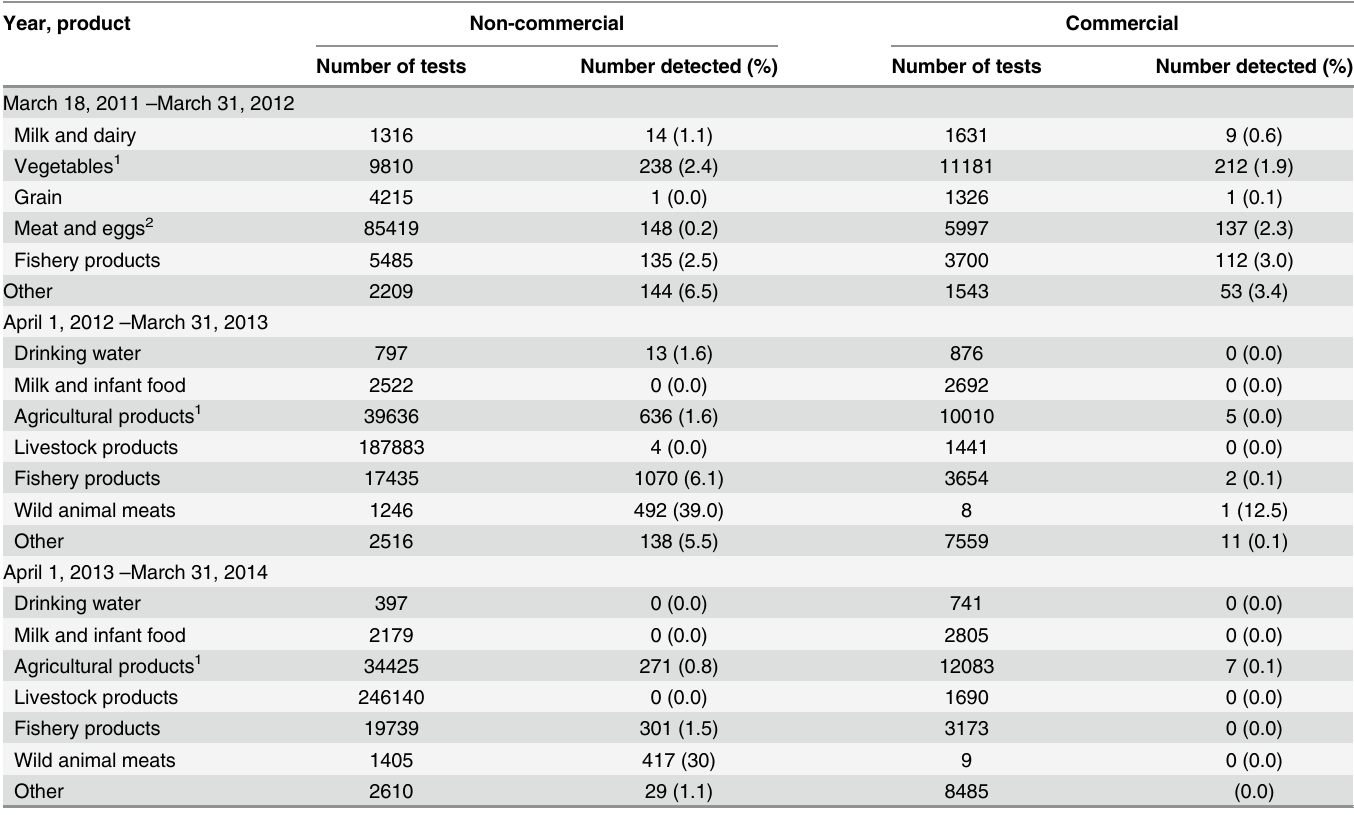
Table 2. Tests over residue limits by Prefecture and food type, 2011 –